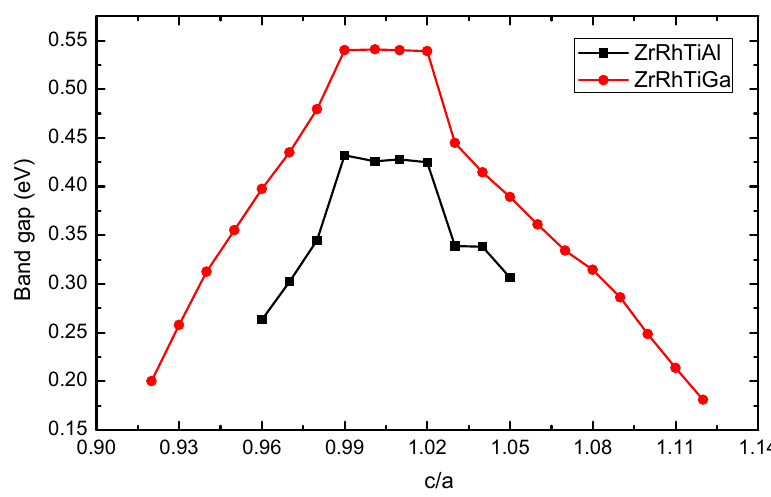
Figure 12. Band gaps as functions of the c/a ratio (TD) for ZrRhTiAl and ZrRhTiGa. Appl. Sci. 2018 , 8 , x